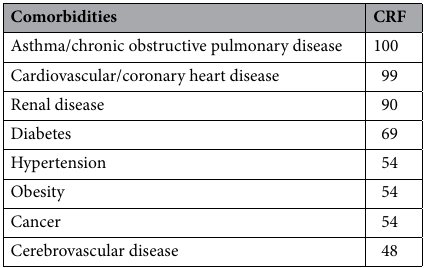
Table 1. Relative risk of existing health condition to COVID-19.